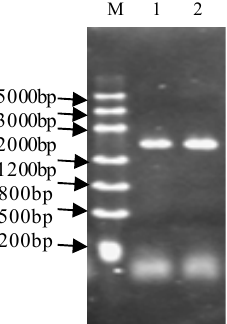
Figure 1. PCR product of CsHPL in cucumber. M : DL 5000 Marker; 1 : PCR product of No. 14-1; 2 : PCR product of No. 26.